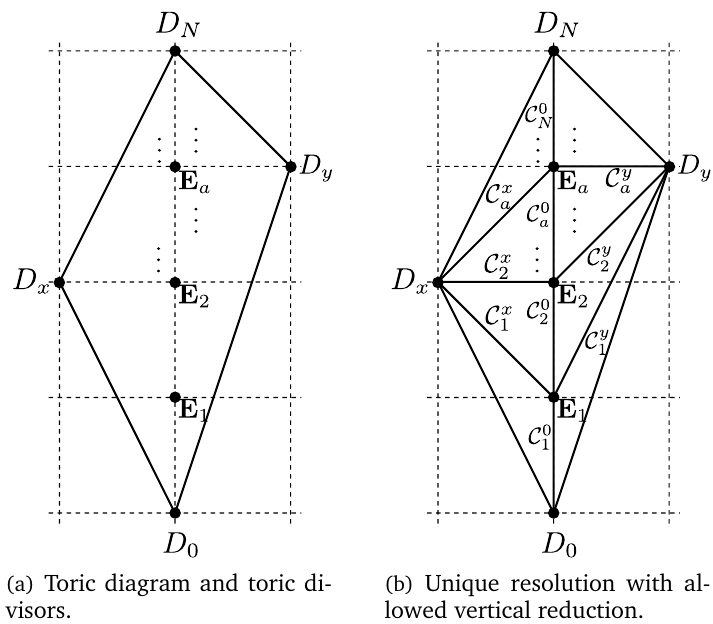
Figure 14: A rank- ( N − 1 ) toric singularity and its unique resolution with an “allowed” vertical reduction, leading to an SU ( N ) gauge theory on D6-branes in type k